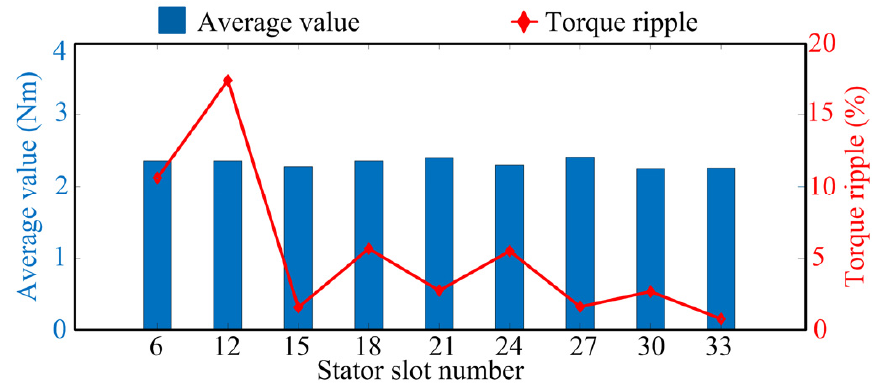
Figure 5. The average value and torque ripple of electromagnetic torque under different numbers of stator slots when the number of rotor poles is 4.